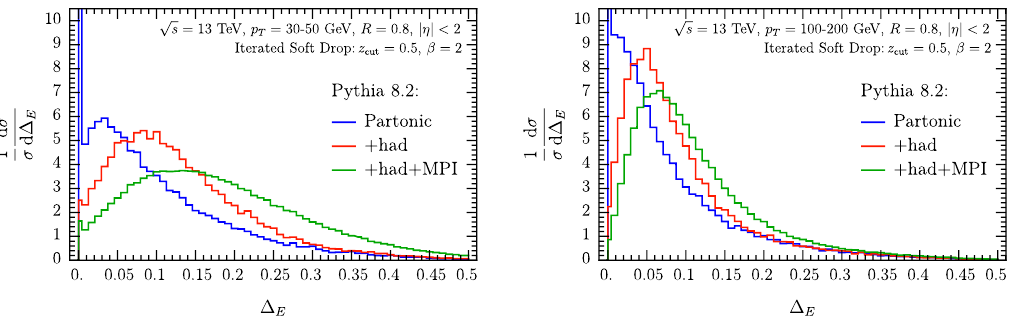
Figure 9 . Pythia results for the jet energy drop with iterated soft drop at parton level (blue), including hadronization (red) and also MPI (green), for p T = 30 − 50 GeV (left) and 100 − 200 GeV (right). Note that these curves are normalized on the full ∆ E